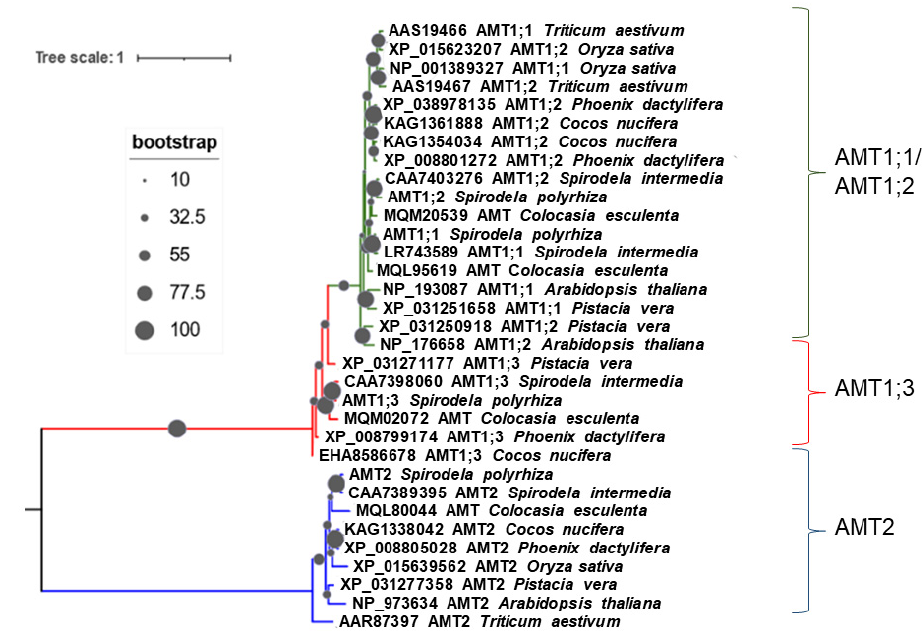
Figure 2. Clustering of AMT protein sequences from selected plant species. The phylograms shows a maximum likelihood tree obtained using available AMT protein sequences from different plants. Multiple alignment and phylogenetic tree were generated in NGPhylogeny webservice (https://ngphylogeny.fr, accessed on 27 September 2022) [47] and iTOL (https://itol.embl.de, ac- cessed on 29 September 2022) [48].